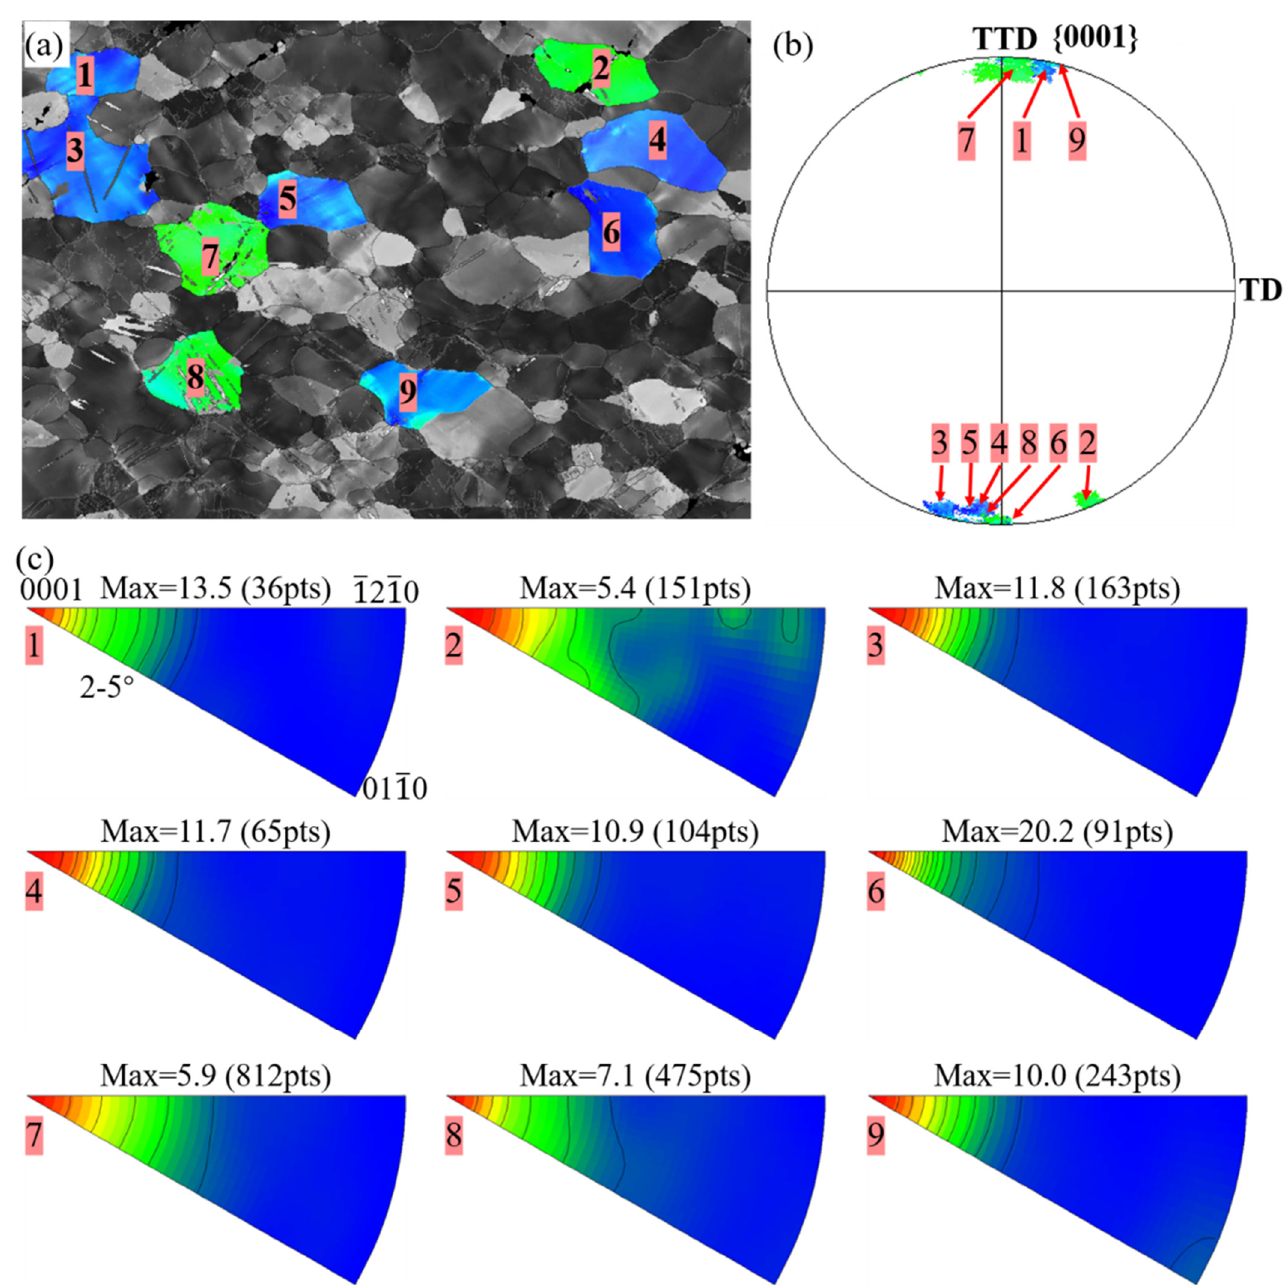
Figure 9. IGMA distribution for representative grains after bent ED bar: ( a ) inverse pole figure maps of the selected grains; ( b ) pole figures of the selected grains; ( c ) calculated IGMA of the selected